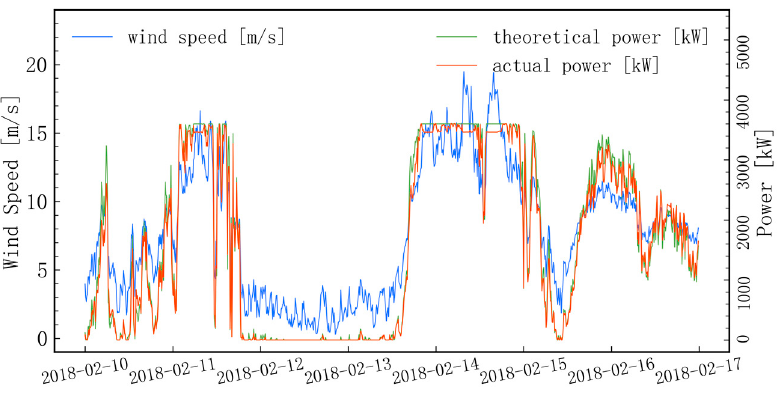
Figure 6. Power–wind speed curve.